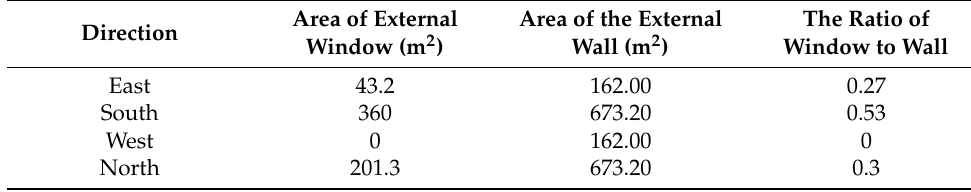
Figure 2. The selected typical office building in Lhasa: ( a ) north facade; ( b ) south facade; ( c ) west faced. Table 1. The window-to-wall ratio of the office building.